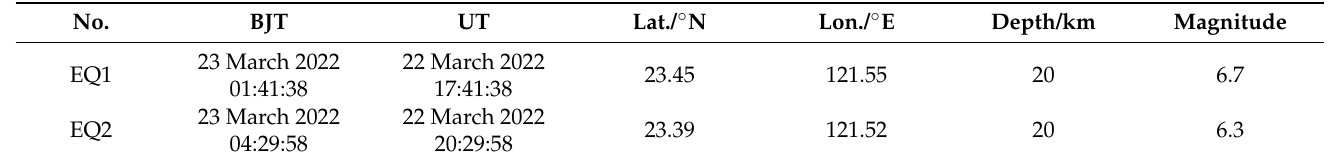
Figure 1. ( A ) Spatial map of Taiwan and the surrounding region and spatial distribution of the seismic activity in map view. The red dots are 138 events (M ≥ 5.0) that are chosen from the earthquake catalogue (February 2019–March 2022) of CENC. The yellow box shows the location of the schematic diagram ( B ); ( B ) a schematic diagram exhibiting the structure of the subducting Eurasian and Philippine Sea slab along the Ryukyu trench and Manila trench. The red box indicates the spatial distribution of two consecutive earthquakes; ( C ) spatial distribution of the 2022 M 6.7 (EQ1) and M 6.3 (EQ2) Taitung Sea earthquakes. Table 1. Detailed information about EQ1 and EQ2 in Taitung Sea.